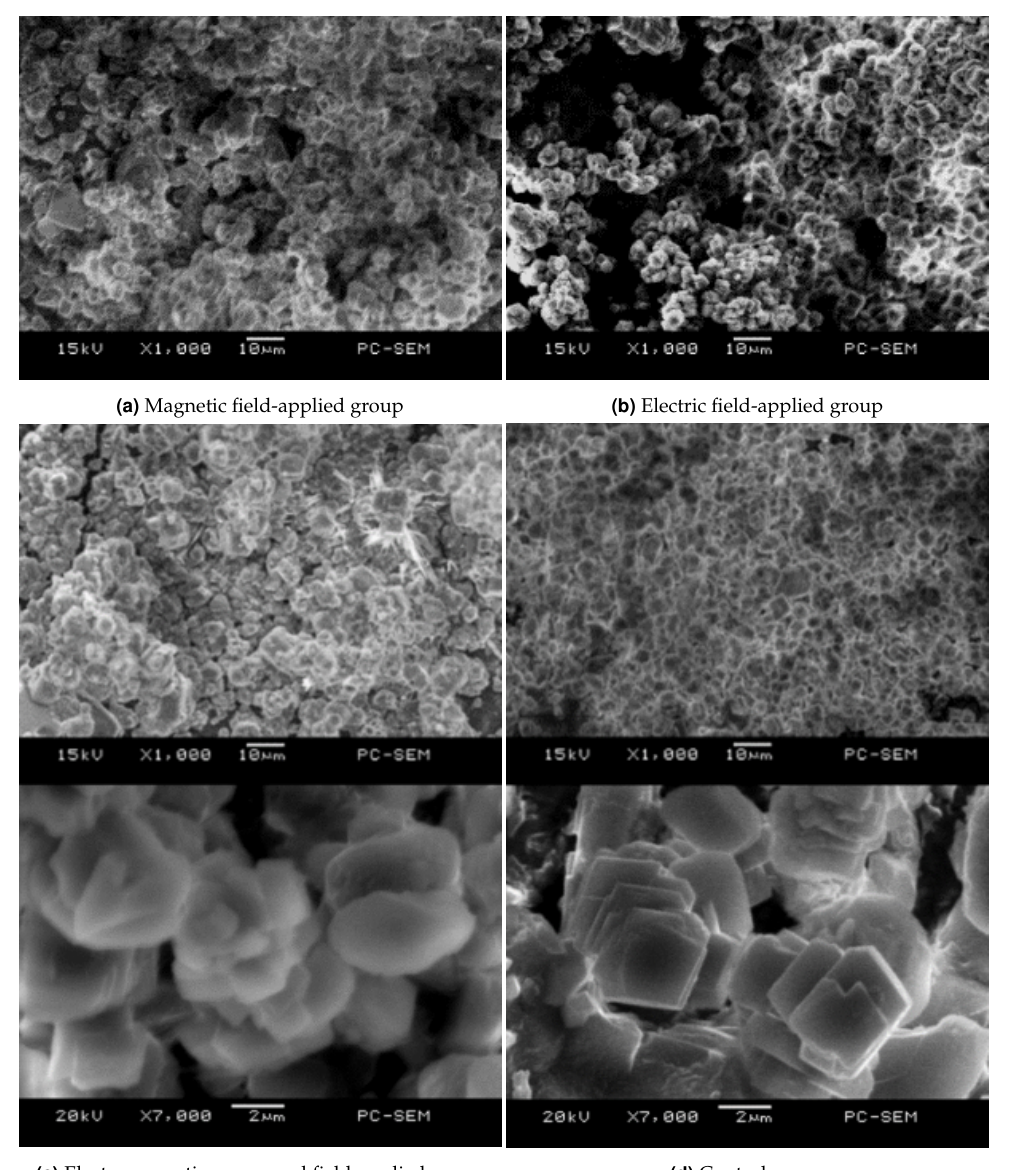
Fig. 15. SEM images of crystals (-1000X or